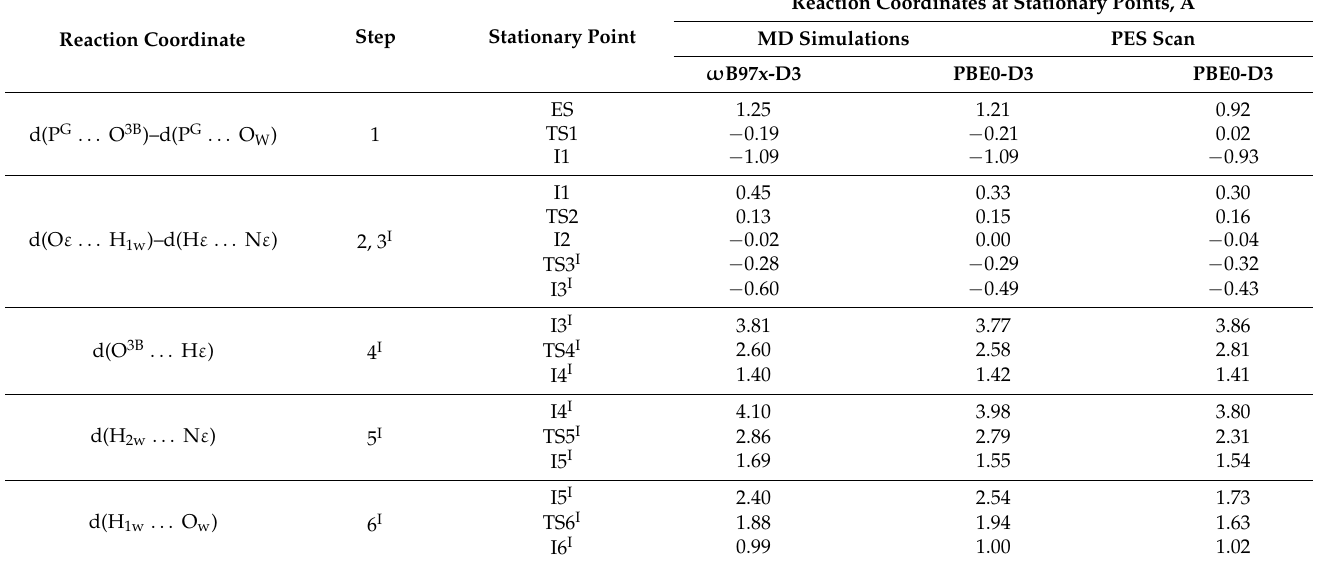
Table 1. Reaction coordinates utilized in the umbrella sampling of the Gibbs energy surface. Reaction coordinate values are calculated for stationary points in MD simulations with the ω B97x-D3 and PBE0-D3 functionals in this study and with the PBE0-D3 in [26] are also shown.